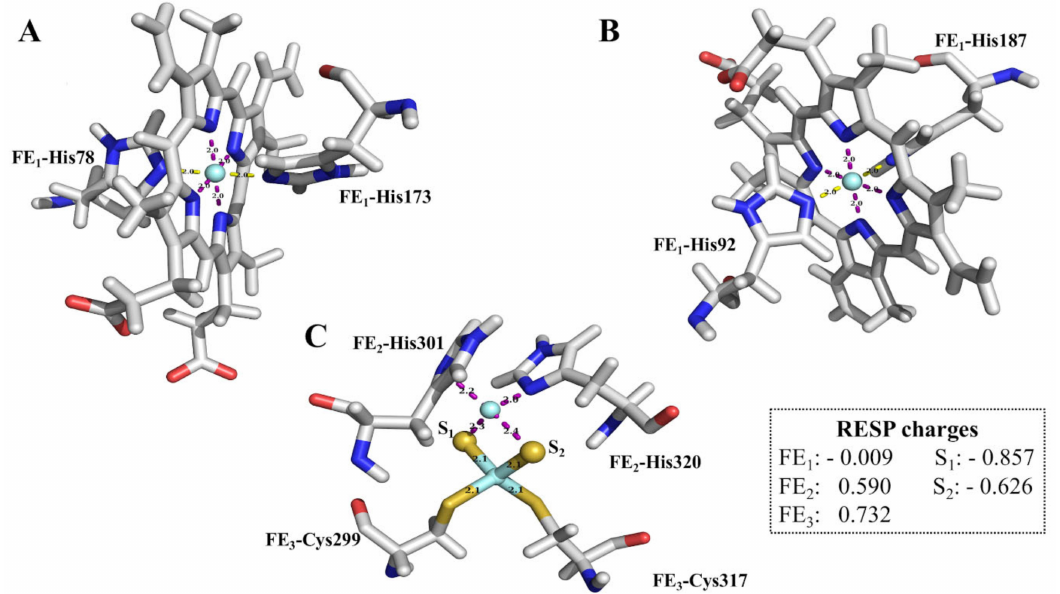
Figure 4. Graphical stick representation of the Quantum mechanics optimized sub-structures of the three prosthetic groups ( A ) Heme bL; ( B ) Heme bH; ( C ) [2FE-2S] cluster. Fe 2+ metal, nitrogen, sulphur, oxygen and carbon atoms are shown in cyan, blue, mustard, red and grey color, respectively. The dashed purple lines represent the chemical